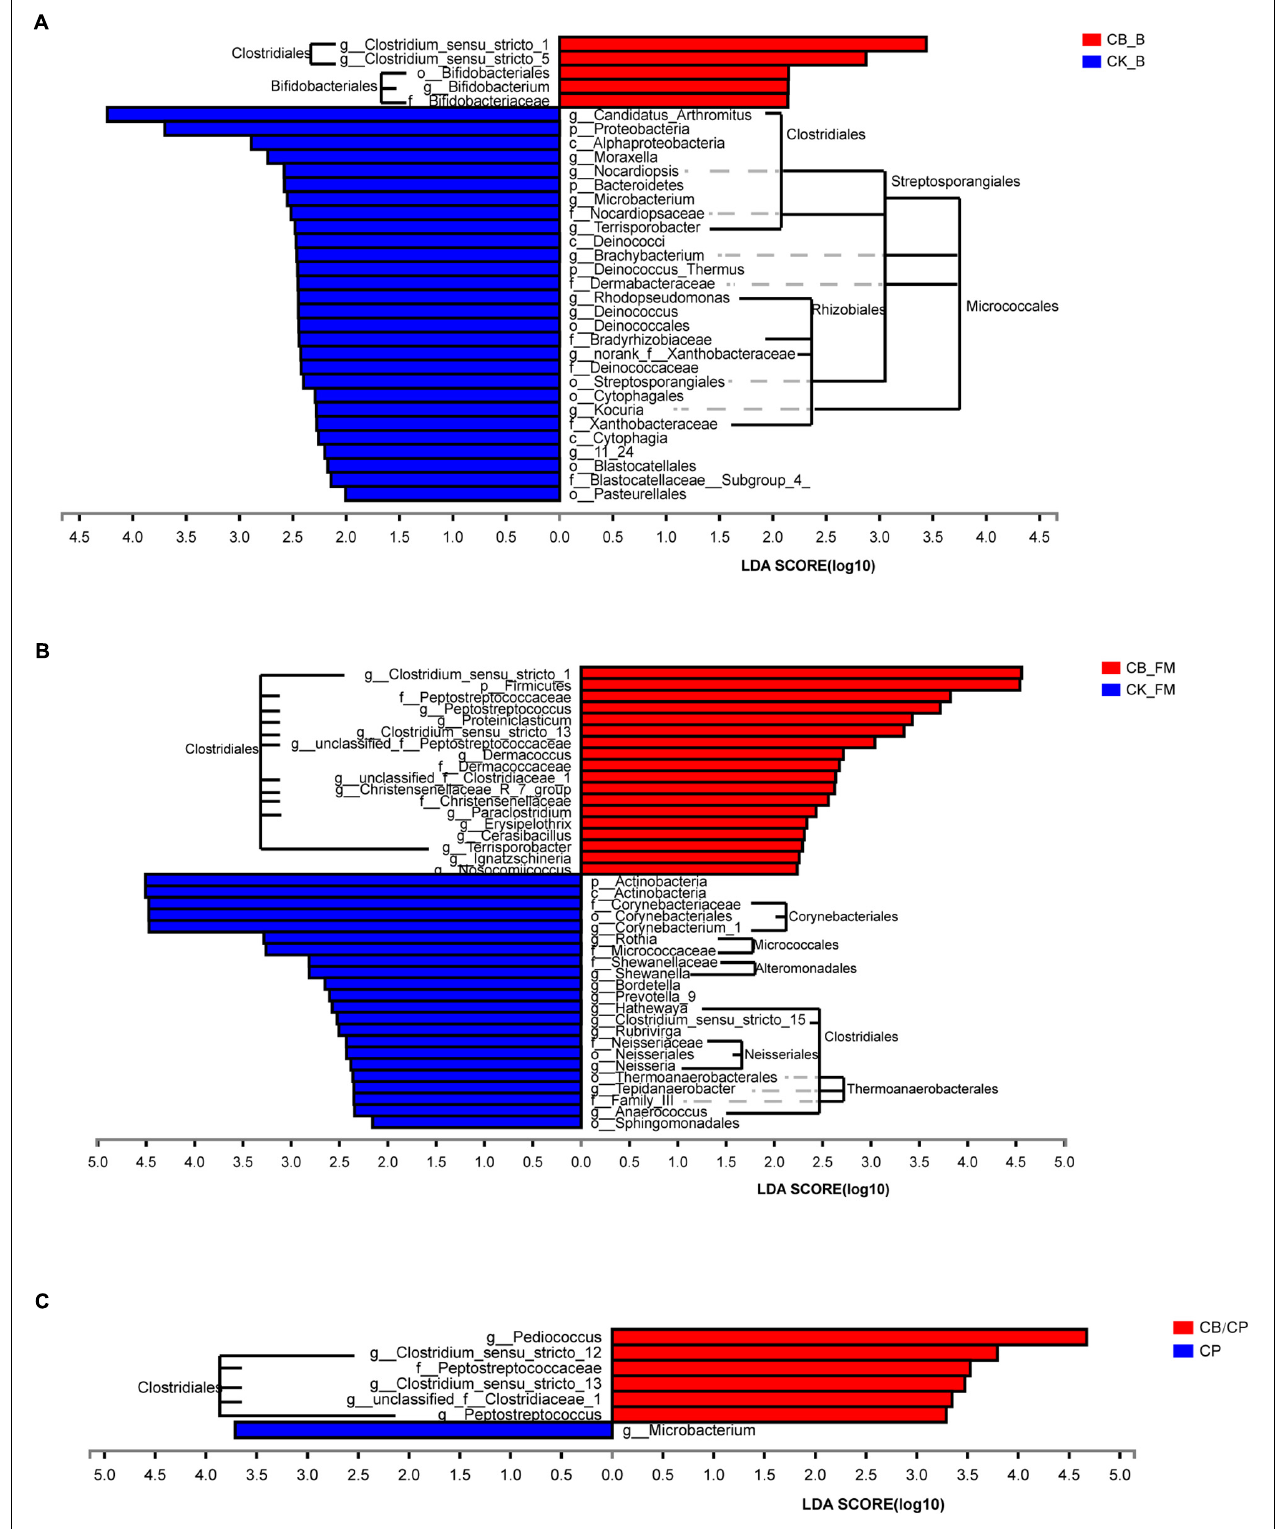
FIGURE 6 | Differential enrichment of intestinal microbiota between groups measured using LEfSe (LDA score = 3). Bars represent significant abundance from phylum to genus between (A) the CB_B and CK_B groups, (B) the CB_FM and CK_FM groups, (C) and the CB/CP and CP groups. CB_B, CK_B, CB_FM and CK_FM: n = 12; CB/CP, CB, CP and CK: n = 6.